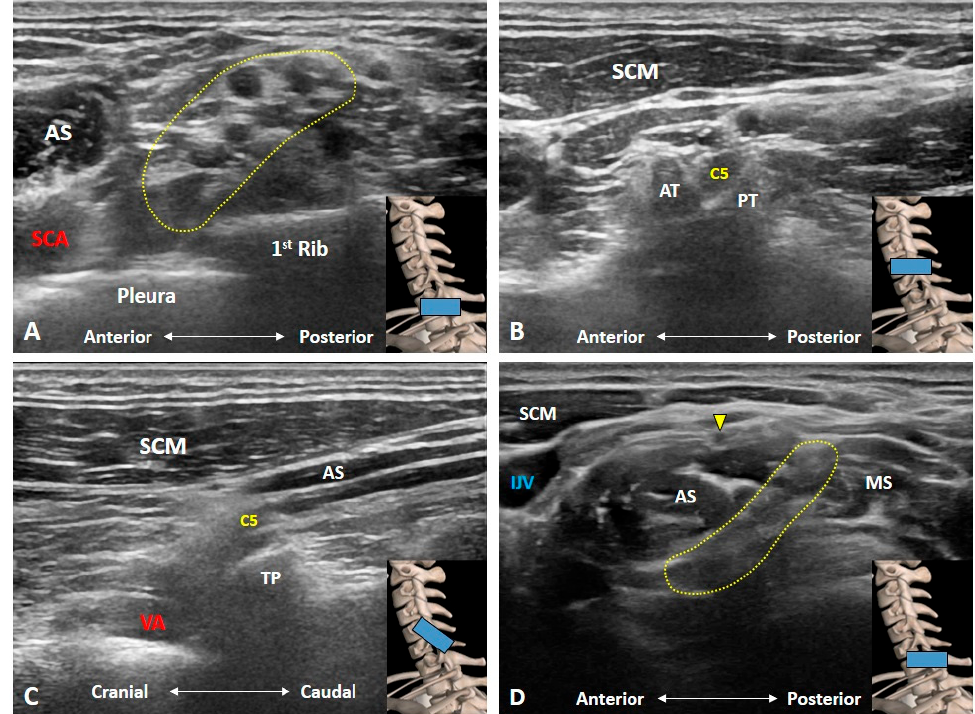
IJV: internal jugular vein; MS: middle scalene muscle; PT: posterior tubercle; SCA: subclavian artery; SCM: sternocleidomastoid muscle; TP: transverse process; VA: vertebral artery. The yellow dashed area encircles the brachial plexus and the blue rectangles at the bottom-right corners represent the transducer